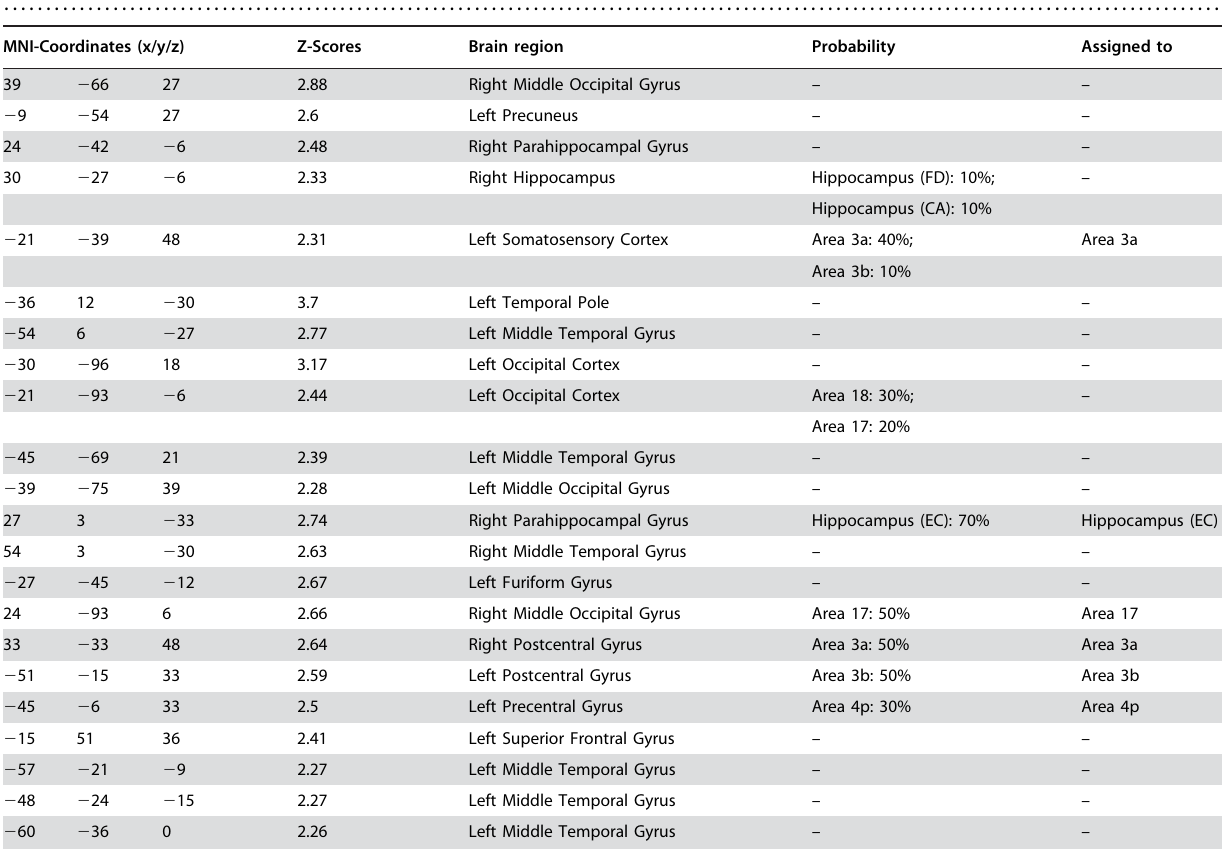
– – – – Right Superior Temporal Gyus – – The corresponding brain region and the probability and assignment to a probabilistic-anatomical map is displayed as calculated with the SPM Anatomy Toolbox [14]. Three peaks in left insular cortex (*) were activated by listening to actively learned melodies in contrast to listening to passively learned melodies at the following statistical threshold: p , 0.005, K . 100, Z-scores . 3.0. Table 1 also shows additional peaks activated by the same contrast at a lower statistical threshold: p , 0.05, K . 50, Z-scores . 2.25.